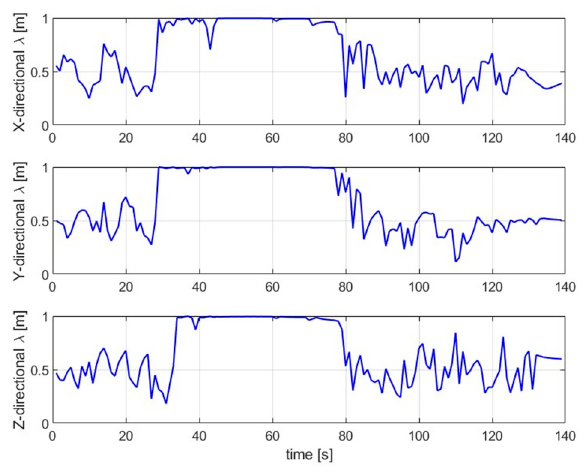
Figure 5. Divergence indices in the fission–fusion process of the UAV swarm without anti-catch situation.